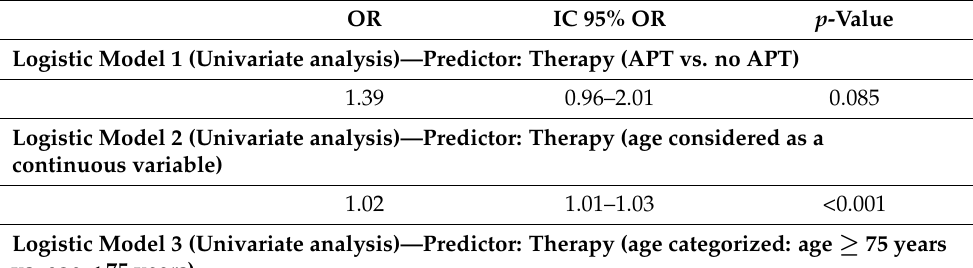
Table 2. Univariate logistic models for bleeding risk. OR IC 95% OR p